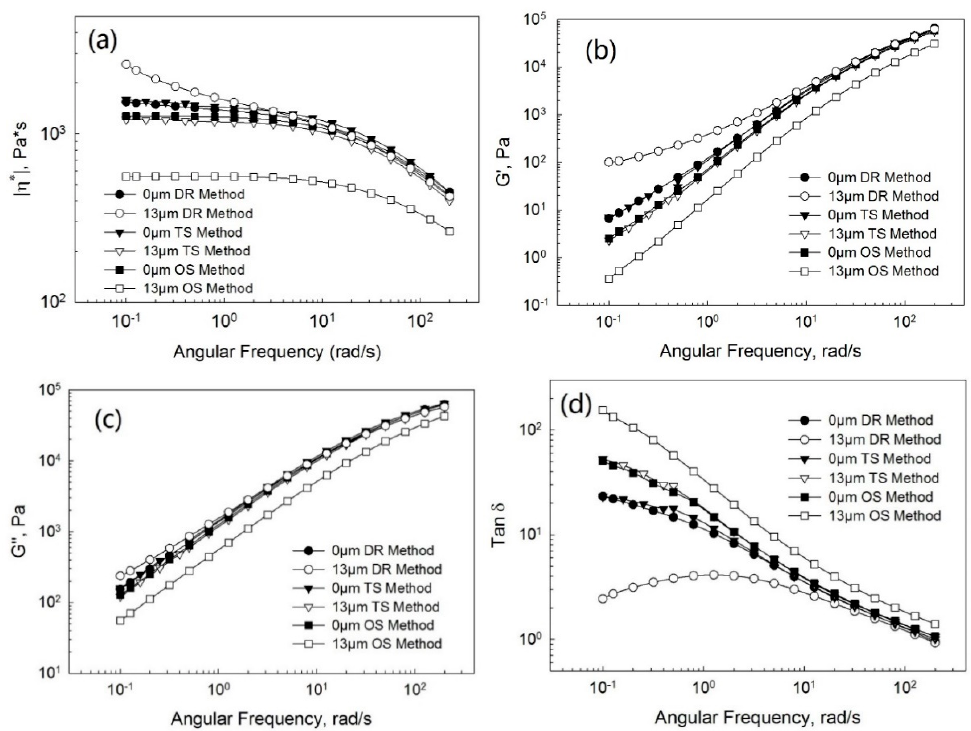
Figure 7. Complex viscosity ( a ), storage modulus ( b ), loss modulus ( c ), and loss tangent ( d ) as a function of the frequency at the ultrasonic amplitudes of 0 μ m (without ultrasonic treatment) and 13 μ m for the PP/EPDM 75/25 blends prepared by the OS, TS, and DR methods.